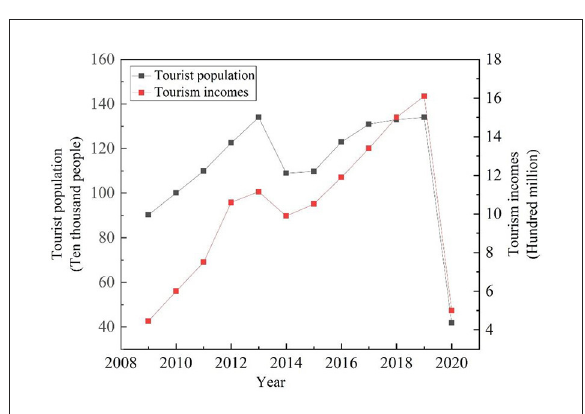
level indices and landscape level indices (50). The study area was examined from the patch-type and landscape levels for this study. Finally, we selected the patch density, aggregation index, landscape shape index, and Shannon diversity index to analyze the landscape changes of the Dachangshan Island. Table 2 presents the meaning of each index and the calculation method. The entire process was performed using Fragstats v4.2.1.